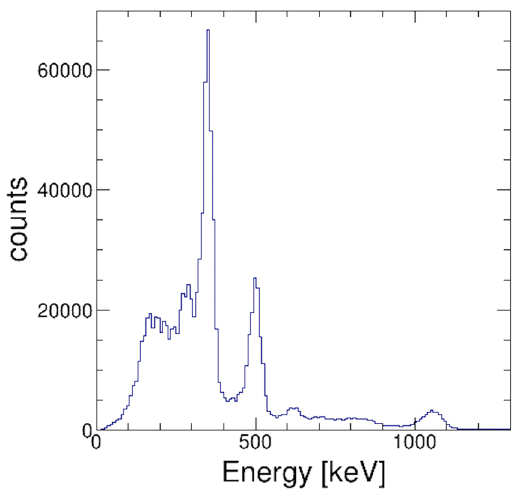
Figure 4. Results of energy spectrum.